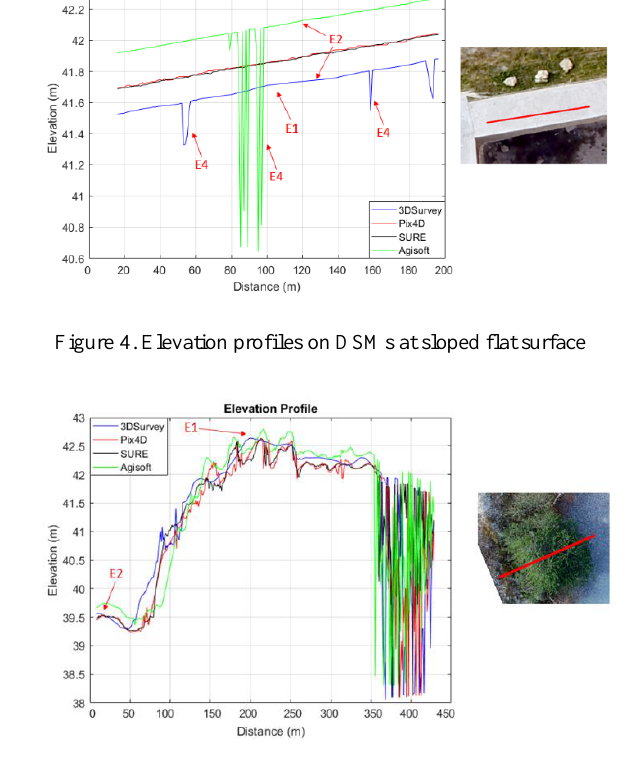
Figure 5. Elevation profiles on DSMs along trees